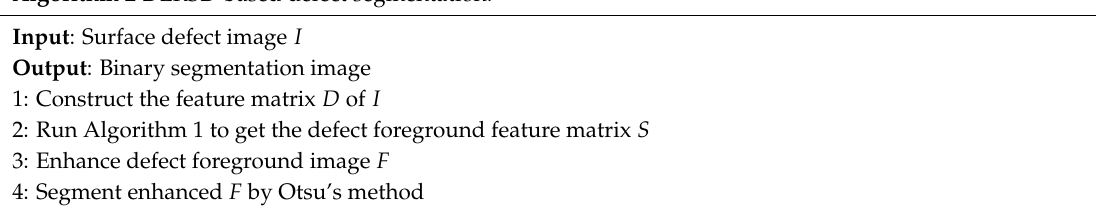
Algorithm 2 DLRSD-based defect